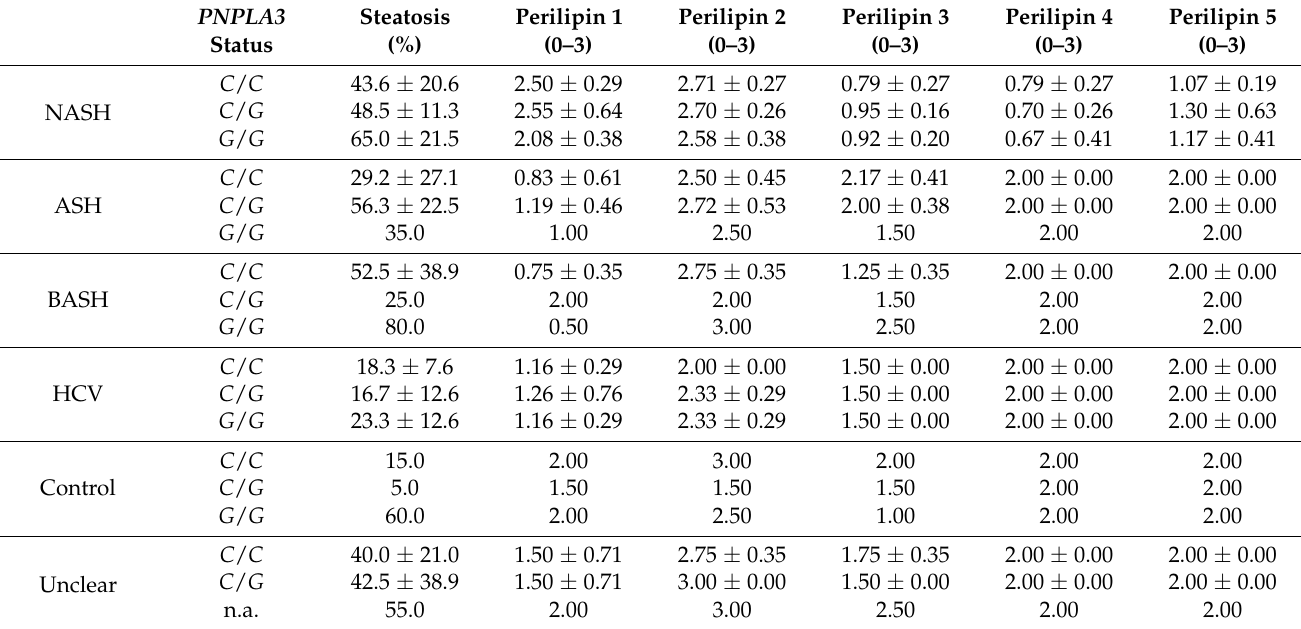
Table 2. Histopathology of liver biopsies with respect to PNPLA3